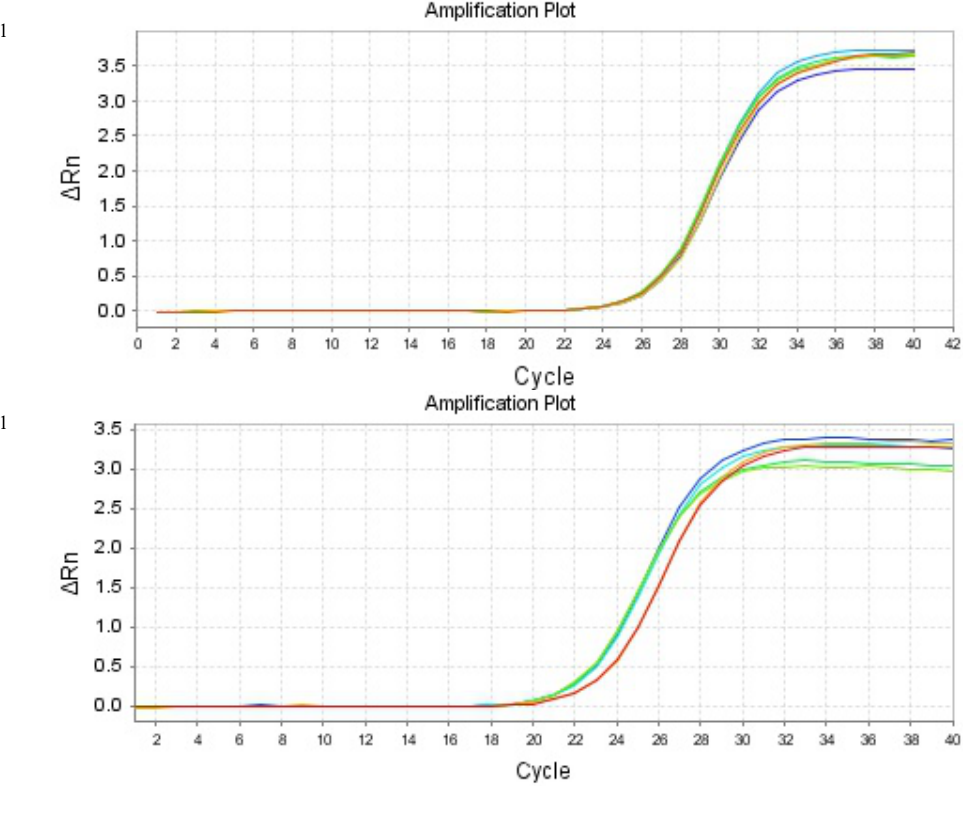
A : amplification curve for PHB; A 1 PAX2; B : melting curve for PAX2; C 2 : amplification curve for β -actin; D for TGF- β l; D 1